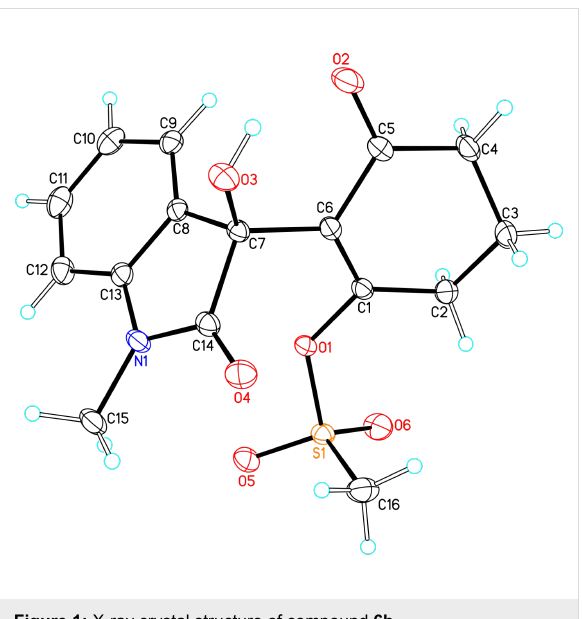
Figure 1: X-ray crystal structure of compound 6b